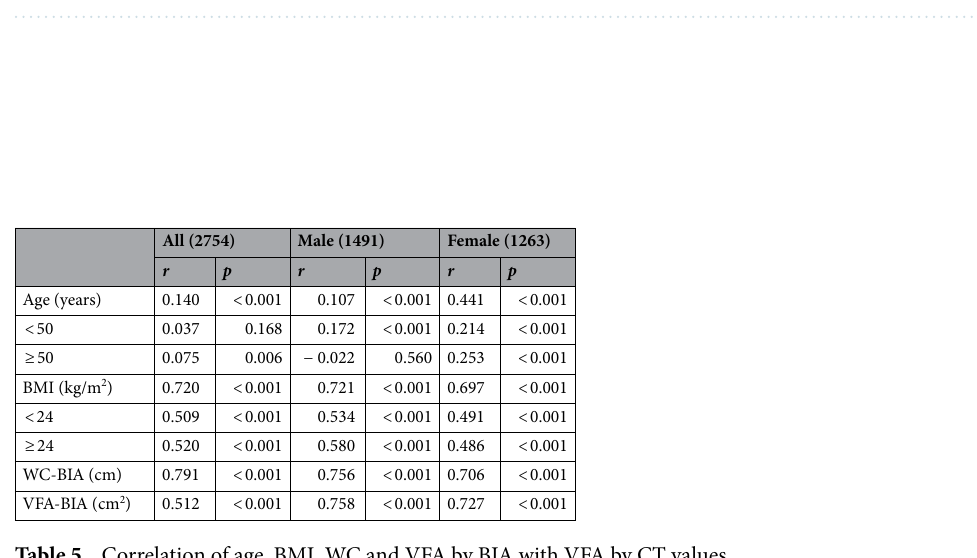
Table 4. The consistency of the VFA between BIA and QCT using the Kappa method according to the gender and age groups.